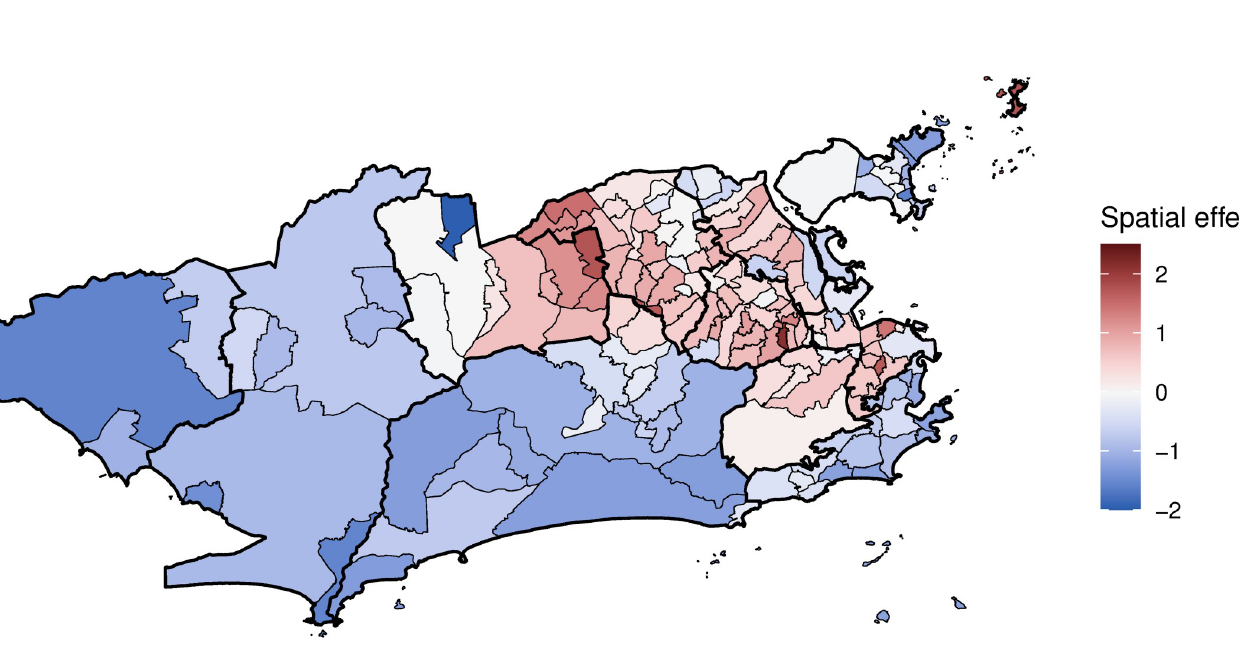
PLOS NeglectedTropical Diseases | https://doi.org/10.1371/journal.pntd.0009537 June 18, 2021 10 /